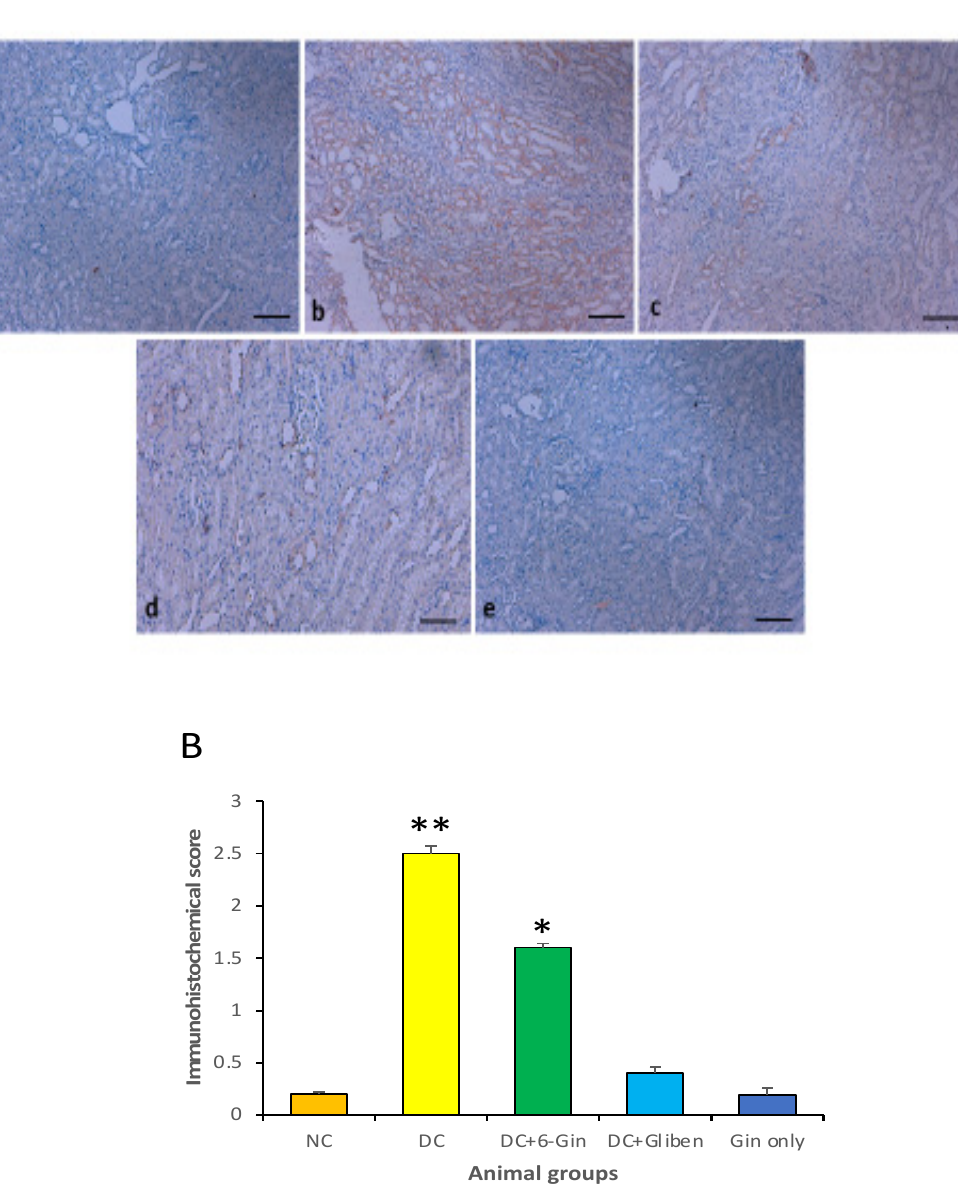
Figure 8. ( A ) (a): The expression of TNF- α protein was not noticed in kidney of normal control group while (b): it showed intense expression in diabetic control group. Moreover, (c): diabetic groups treated with 6-gingerol, exhibited weak expression in diabetic group plus 6-gingerol group. (d): positive control (diabetic rats treated with glibenclamide) not showing any expression, (e): Gingerol-treated group only did not show any expression. (Scale bar = 100 µ m). ( B ): represents the graphical representation of TNF- α expression. The expression pattern was high in the diabetic control as compared to the normal control group (** p < 0.01). The diabetic group treated with 6-gingerol showed low expression as compared to the diabetic control (* p < 0.05). The expression pattern of TNF- α in the positive control and 6-gingerol treated only was statistically insignificant as compared to the control group ( p > 0.05).